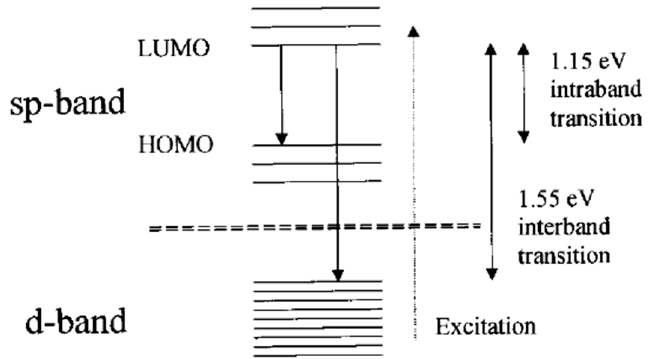
Figure 3. Solid-state model for the origin of the two luminescence bands: The high-energy band is proposed to be due to the radiative interband recombination between the sp and d-bands, while the low-energy band is thought to originate from radiative intraband transitions within the sp-band across the HOMO-LUMO gap (highest occupied molecular orbital and lowest unoccupied molecular orbital). Note that intraband recombination has to involve the prior nonradiative recombination of the hole in the d-band created after excitation with an (unexcited) electron in the sp-band. Reprinted with permission from Ref. [30]. Copyright (2002) American Chemical Society.